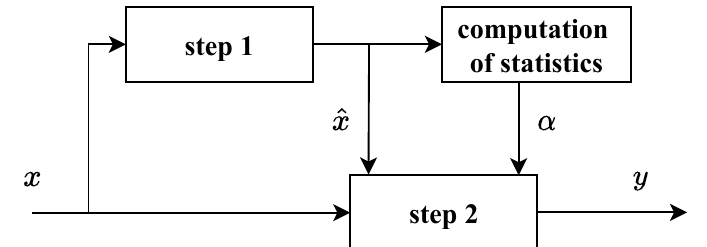
Figure 4. The schematic diagram of the SAR-BM3D algorithm. x denotes the input image, and y denotes the filtered